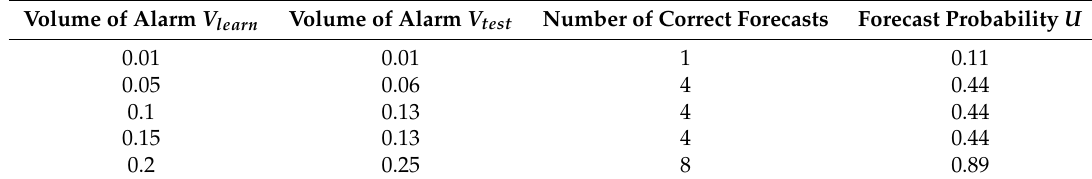
Table 2. Probabilities of earthquake forecast for California.